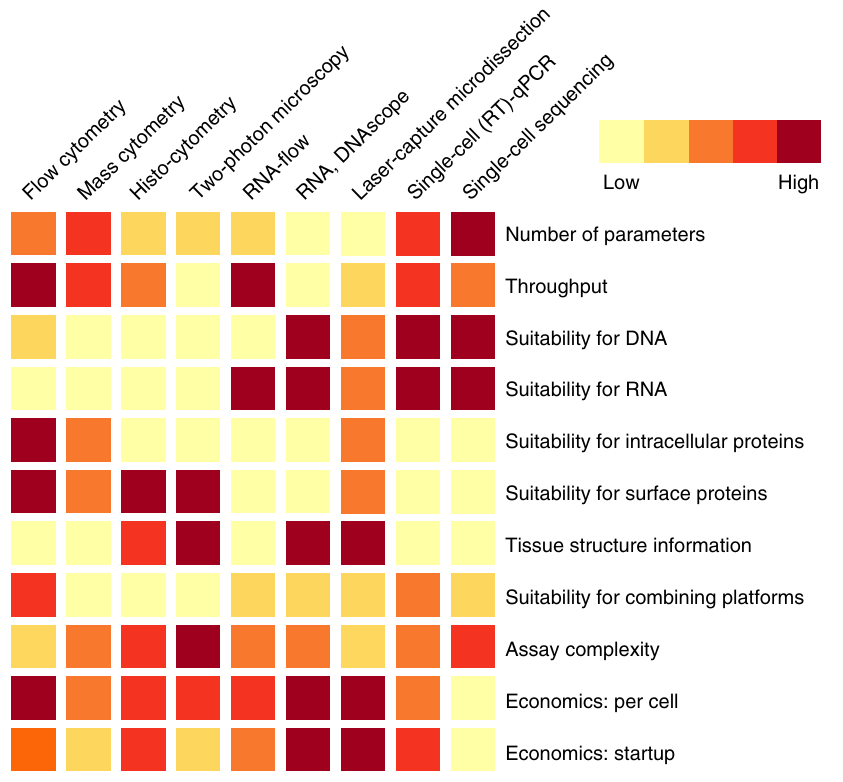
Fig. 2 Heat map comparing various single-cell technology platforms. Relative capabilities of the single-cell technologies listed at top (columns) are depicted for each feature (rows). Performance is ranked from low to high relative to the other technologies using the indicated color